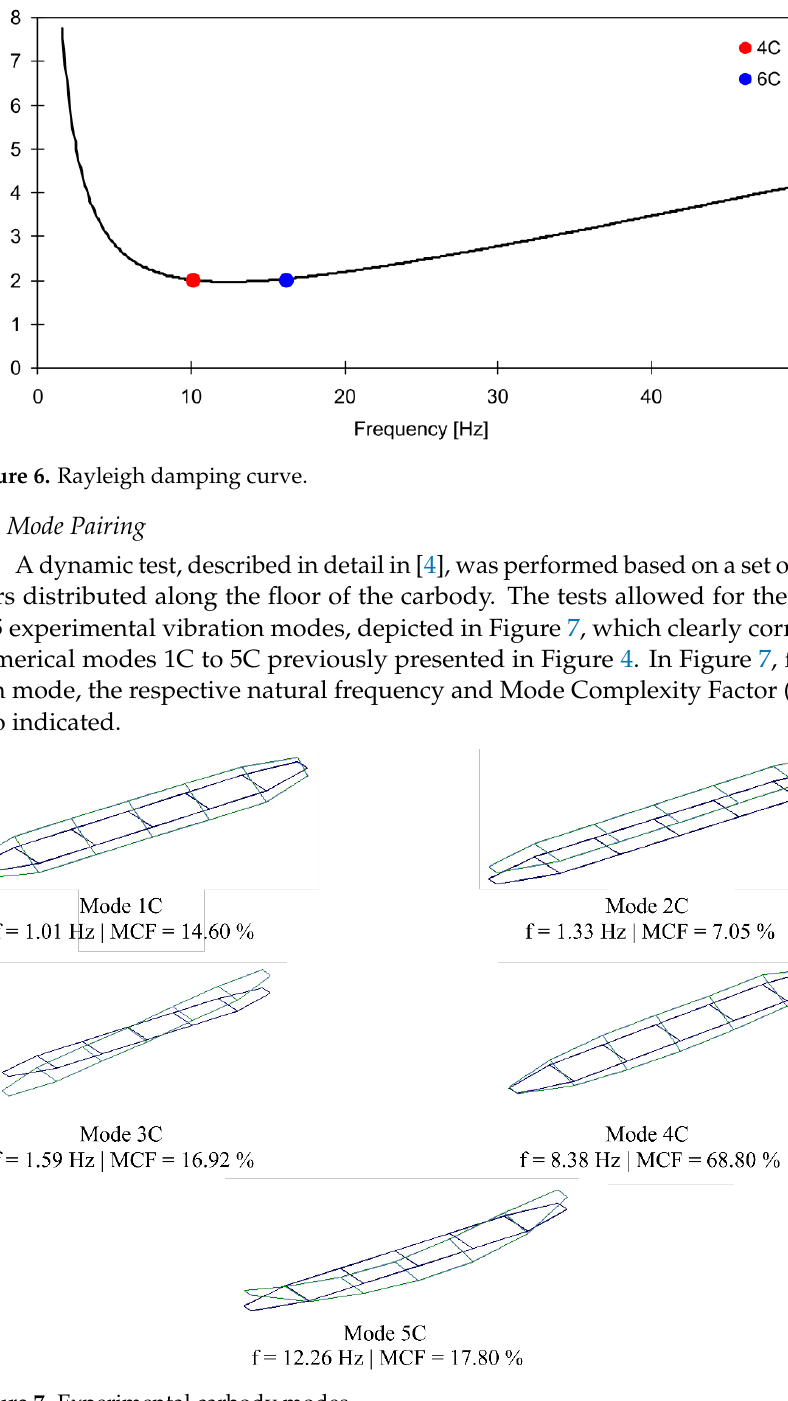
Figure 7. Experimental carbody modes.